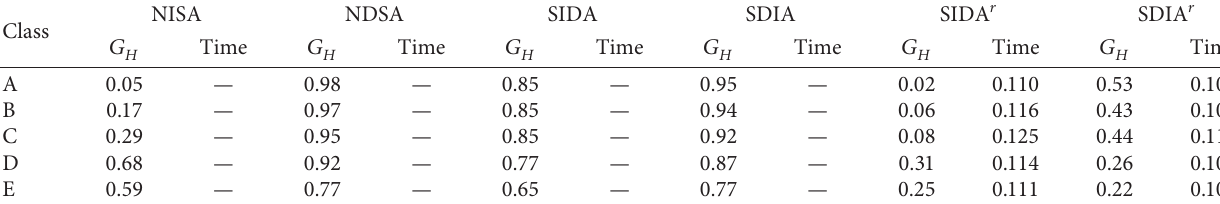
Table 10: The behavior of G H and time when the number of classes is